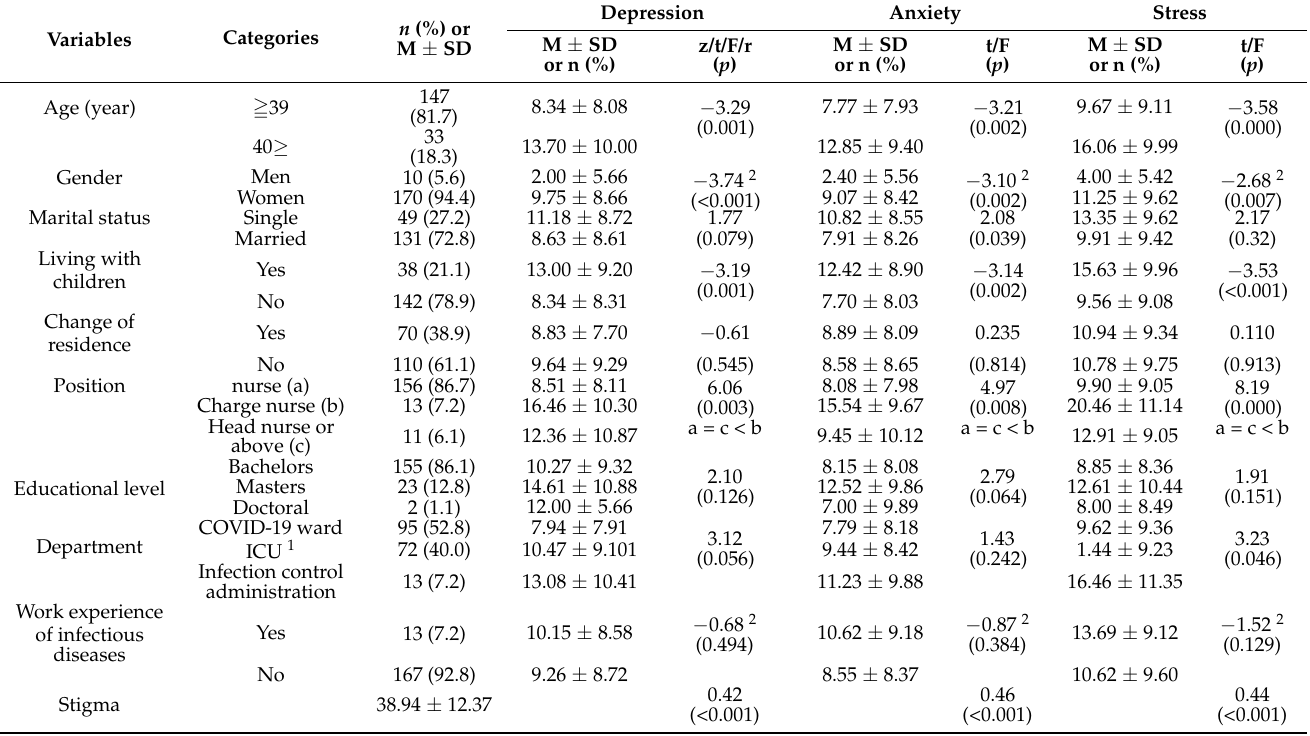
Table 2. Comparison of demographic data and levels of depression, anxiety, stress, and stigma ( n = 180).